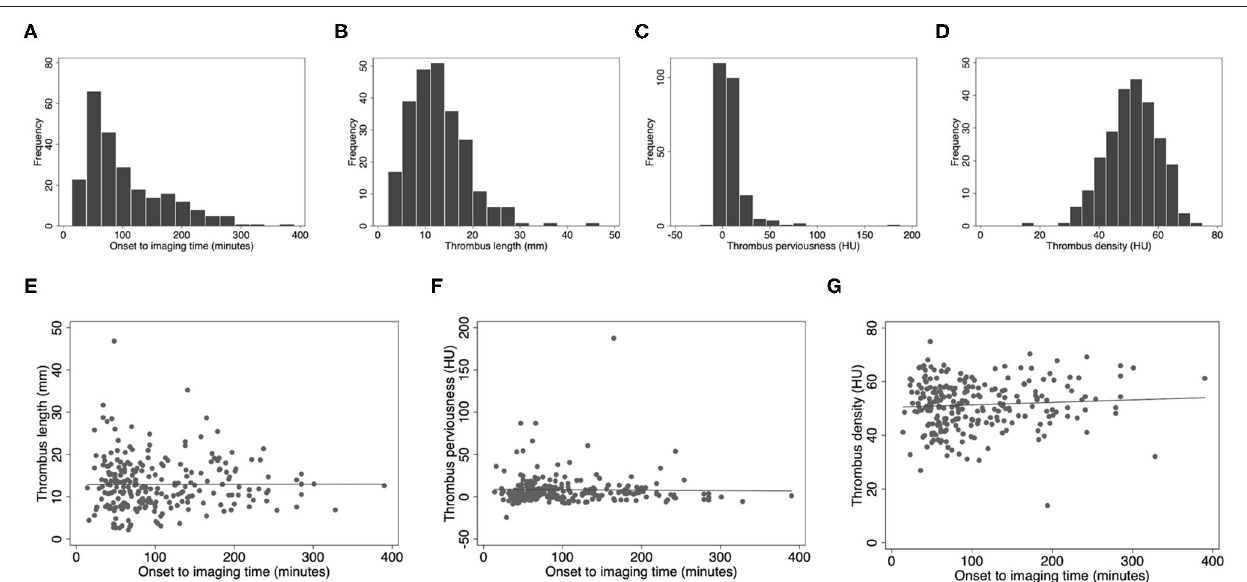
FIGURE 1 | Scatter and box plots of image characteristics. (A) Time from symptom onset to imaging distribution, (B) thrombus length histogram, (C) thrombus perviousness histogram, (D) thrombus density histogram, (E) onset to imaging time vs. thrombus length, (F) onset to imaging time vs. perviousness, (G) onset to imaging time vs. non-contrast CT density. HU, Hounsfield Units; mm, millimeter.